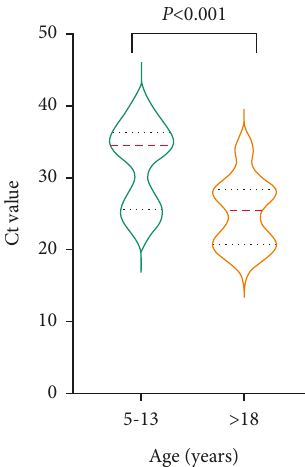
Figure 2: Ct values of nasopharyngeal nucleic acid tests in asymptomatic patients stratified by age.